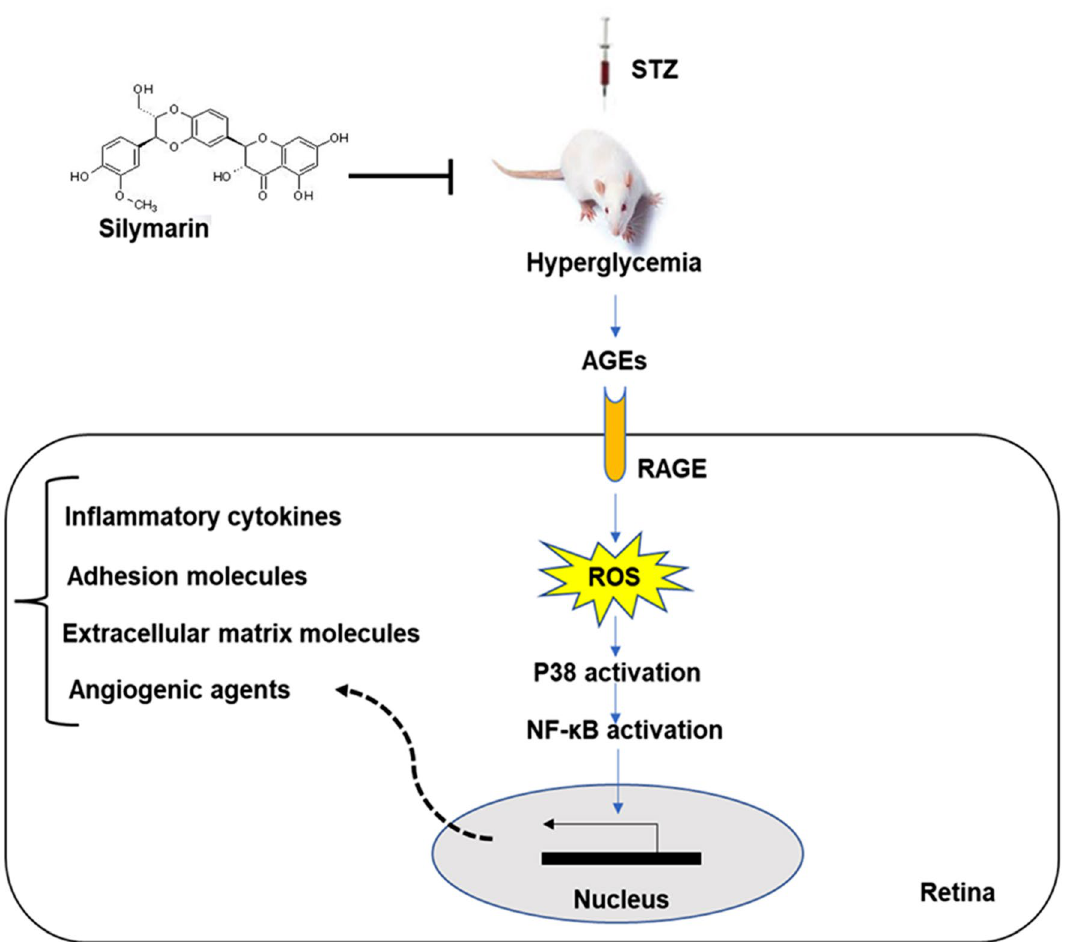
Figure 1. Schematic of the possible effect of silymarin on reducing retinal damage in STZ-induced diabetic